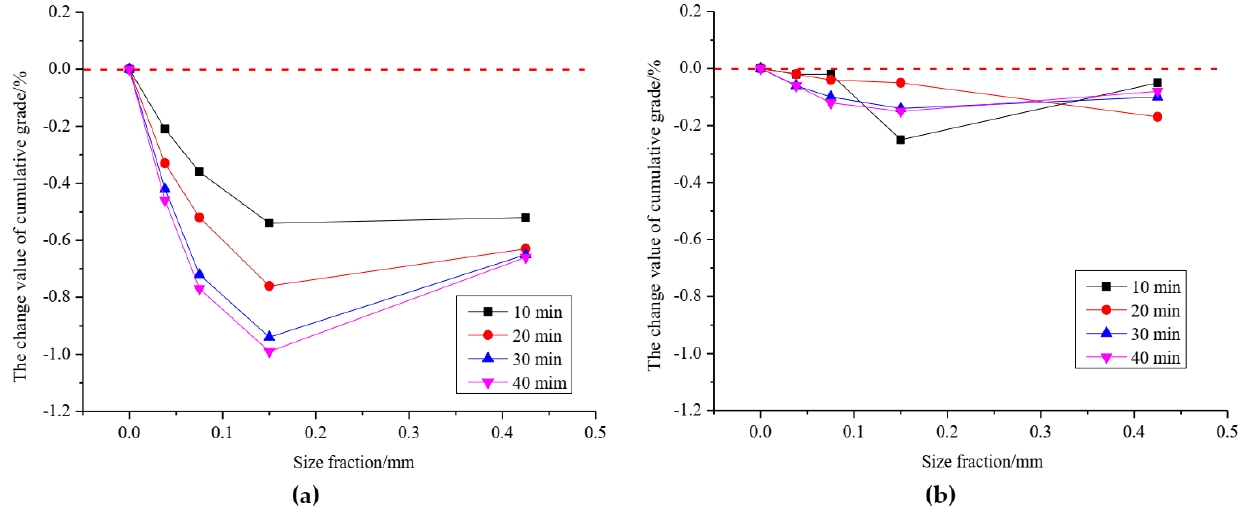
Figure 7. The change in Zn and Sn cumulative grade with size fraction under different grinding time when the mill speed is 12.8 r/min. ( a ) Changes in the cumulative grade for Zn. ( b ) Changes in the cumulative grade for